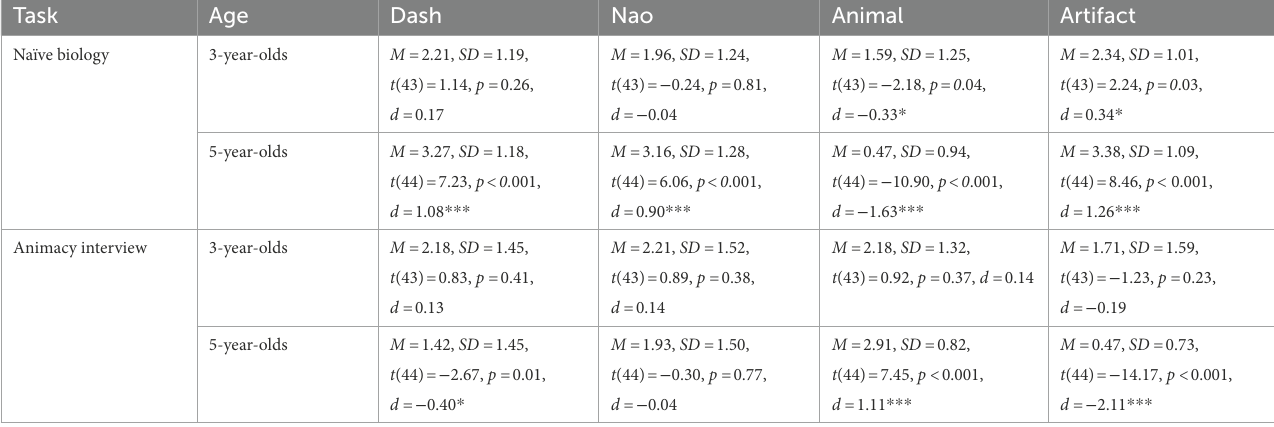
TABLE 1 Mean scores and chance analyses for the Animacy Interview and Naïve Biology task, as a function of age. Task Age Dash